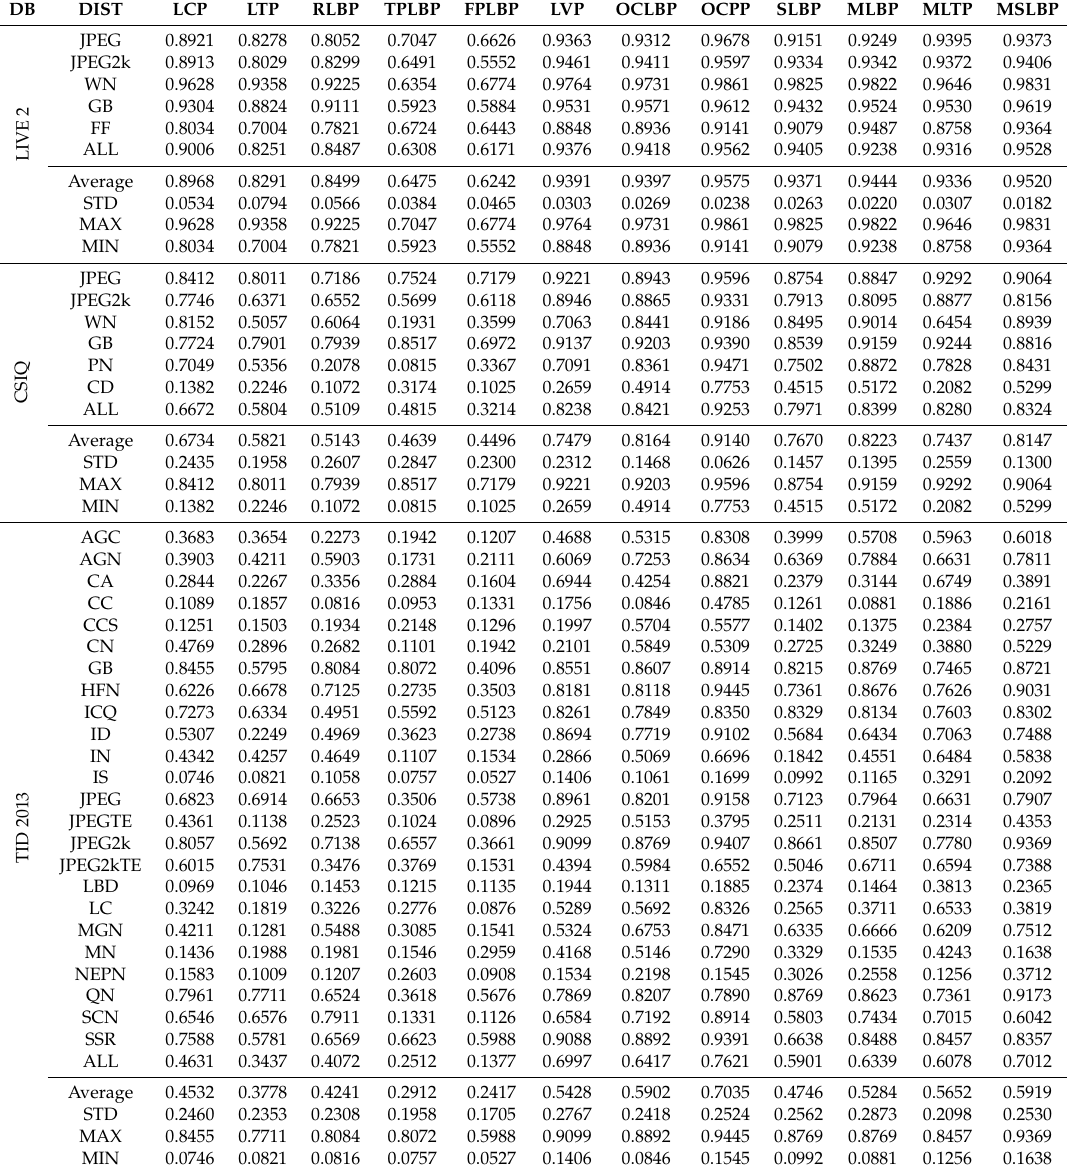
Table 6. Average SROCC of 100 runs of simulations on tested image databases using other LBP